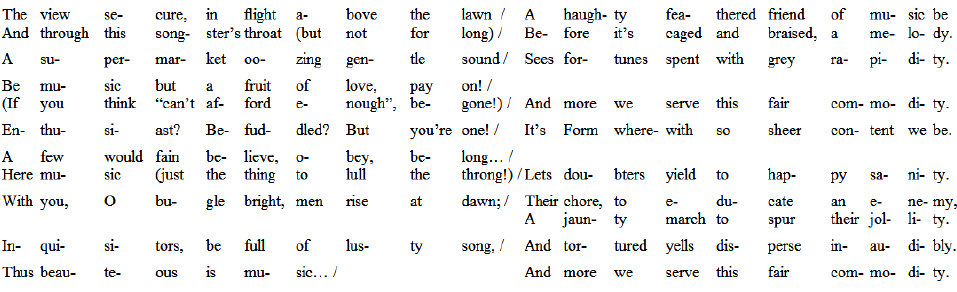
Figure 3: Ode to St. Cecilia with syllables separated into individual phonetically homogenous